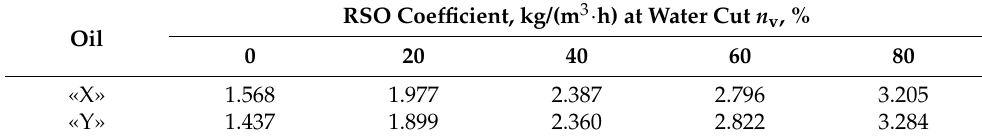
Table 5. RSO results of laboratory investigation.